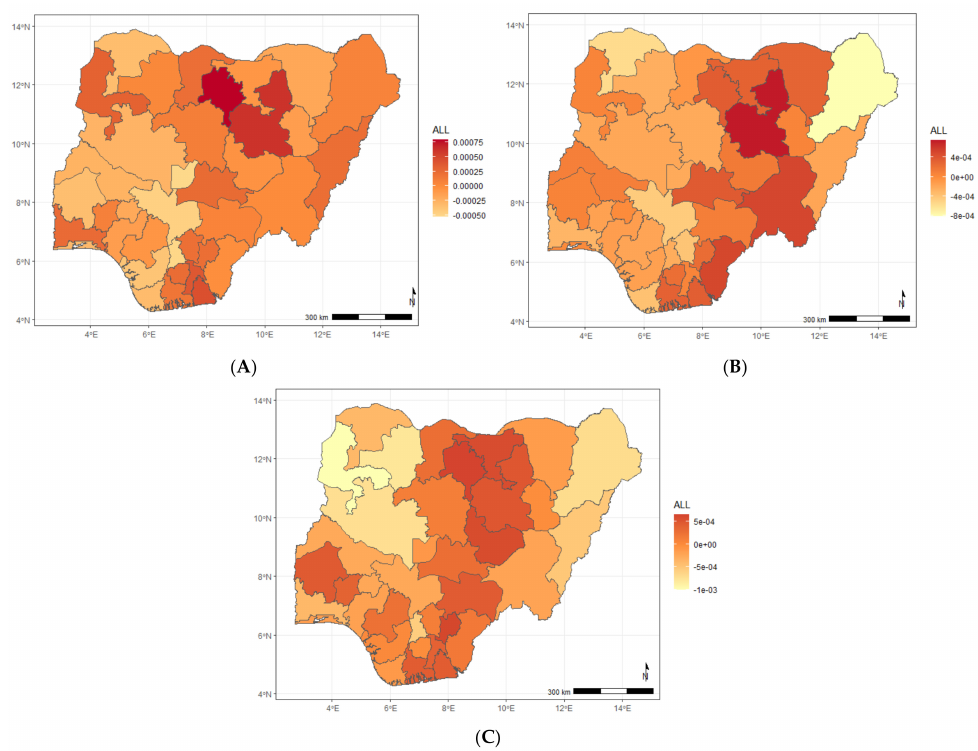
Figure A7. Maps showing posterior estimates of the ARI and diarrhoea and stunting spatial shared effect year of NDHS implementation; ( A ) 2008, ( B ) 2013, ( C )